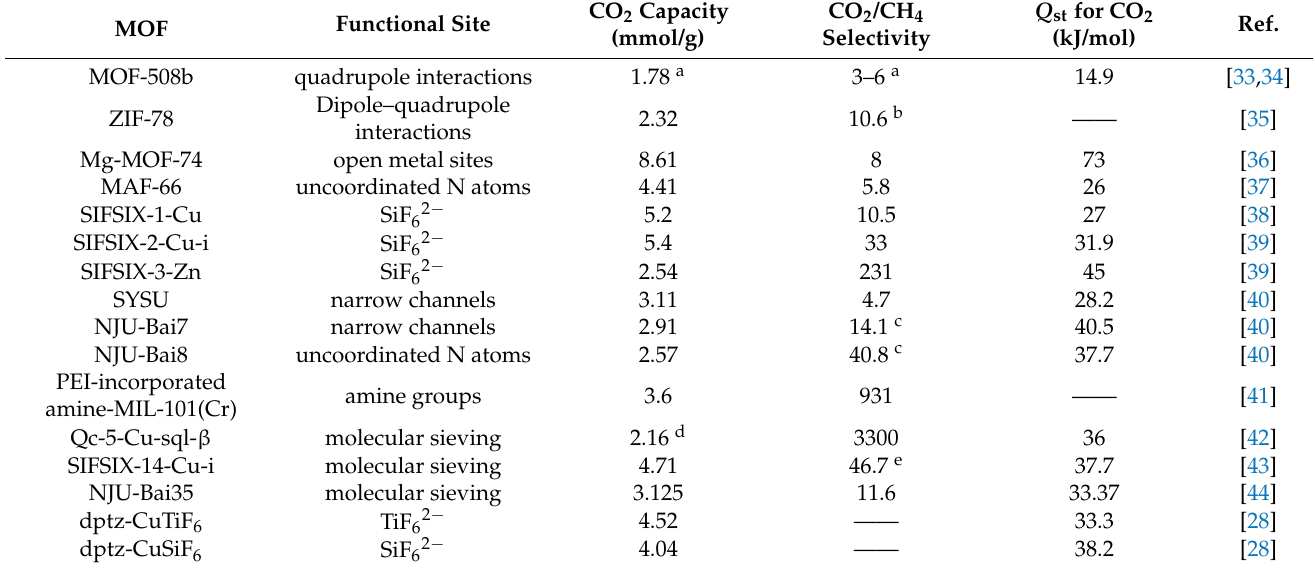
Table 2. Representative MOFs for CO 2 -selective capture from CO 2 /CH 4 mixtures